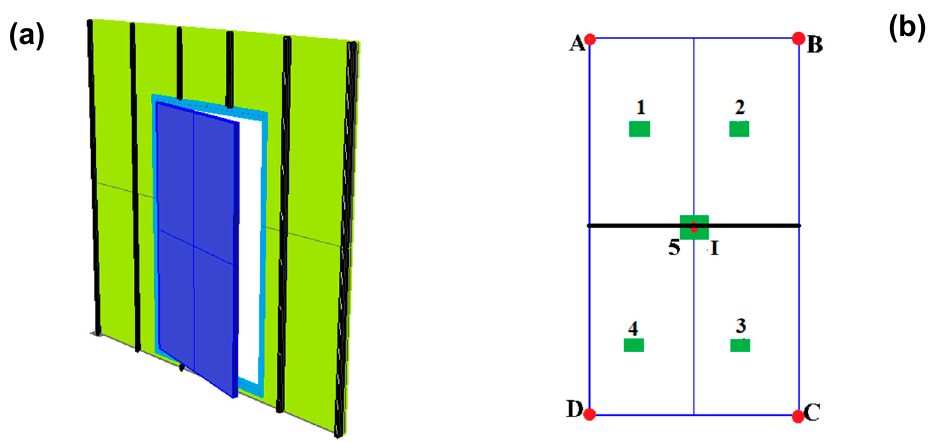
Figure 1. ( a ) Model geometry; ( b ) test measuring points: location of thermocouples (1, 2, 3, 4, 5) and displacements measurements point (A, B, C, D, I).